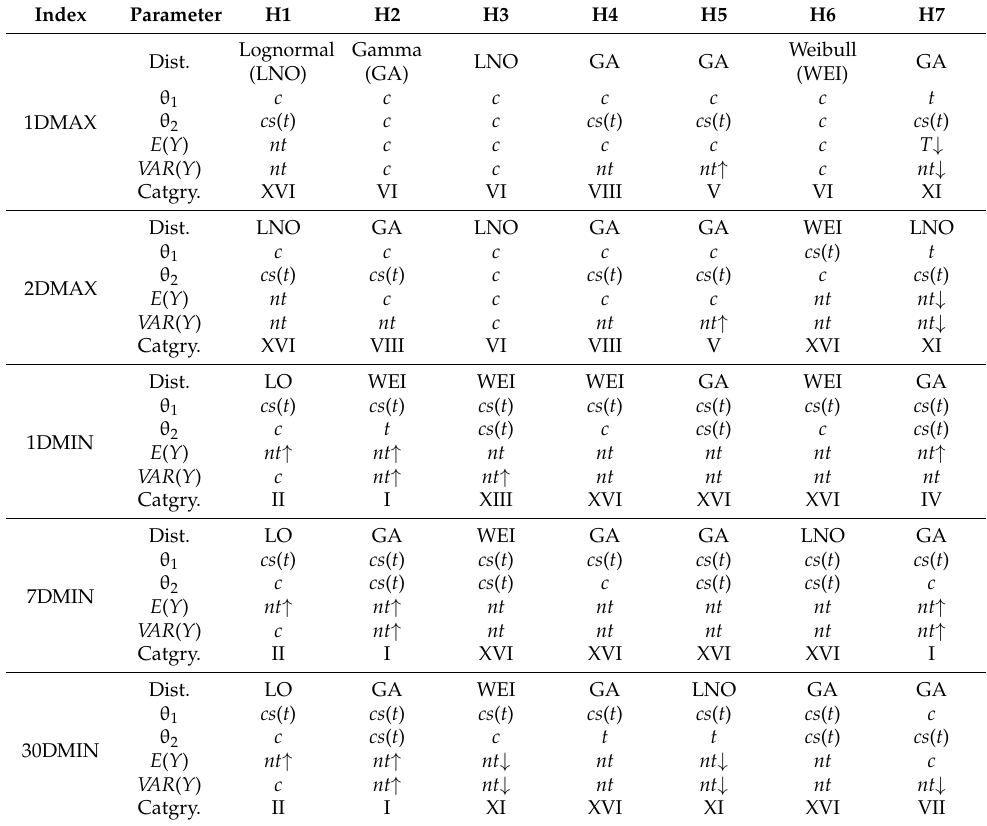
Table 6. Results of the generalized additive models for location, scale and shape (GAMLSS) using time as covariate, corresponding mean and variance variations, and the variation